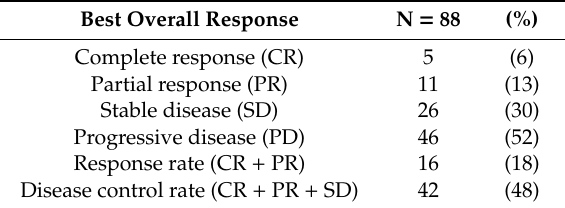
Figure 1. Kaplan–Meier survival curves of ( a ) overall survival (OS) and ( b ) progression-free survival (PFS) on median follow-up time of 25.9 months. ( a ) Median OS: 9.6 months (95% CI, 8.4–12.0), one-year OS: 39.8% (95% CI, 29.6–49.8), and two-year OS: 25.0% (95% CI, 16.4–34.7). ( b ) Median PFS: 3.7 months (95% CI, 2.6–4.6), one-year PFS: 26.0% (95% CI, 17.4–35.5), and two-year PFS: 19.6% (95% CI, 11.9–28.7). Table 2. Best overall response.